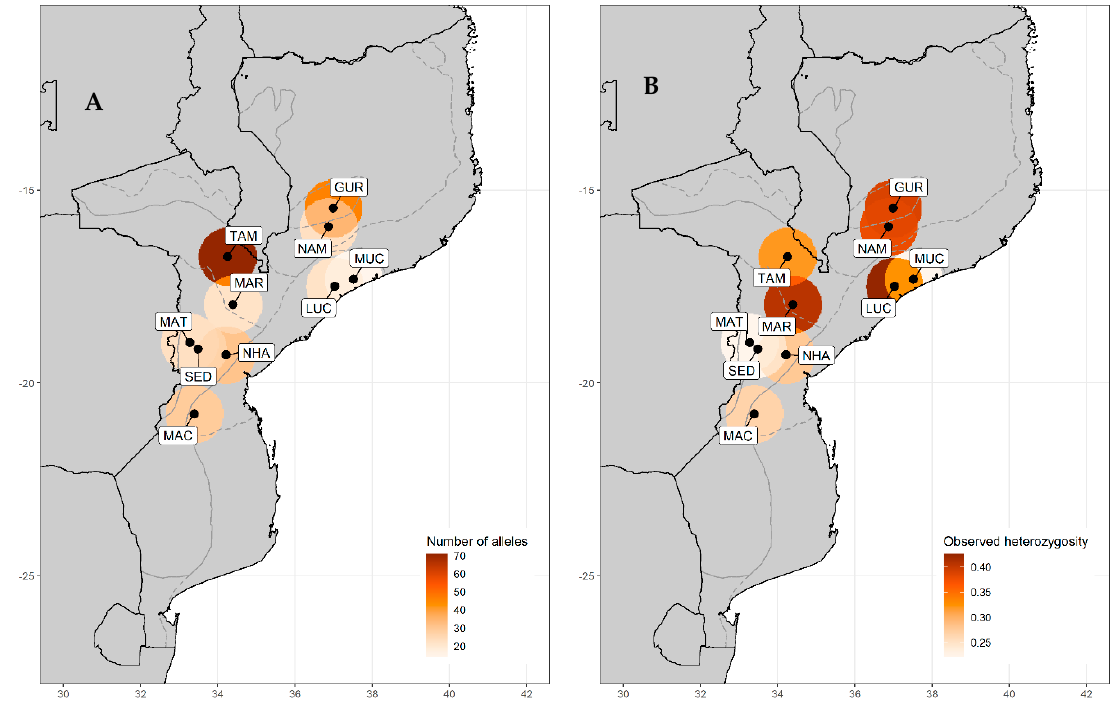
Figure 2. Map of the number of alleles ( A ) and observed heterozygosity ( B ) in 30 s (1 km) grid cells applying a 1-degree circular neighborhood. Dashed lines indicate the borders of agro-ecological zones [16].